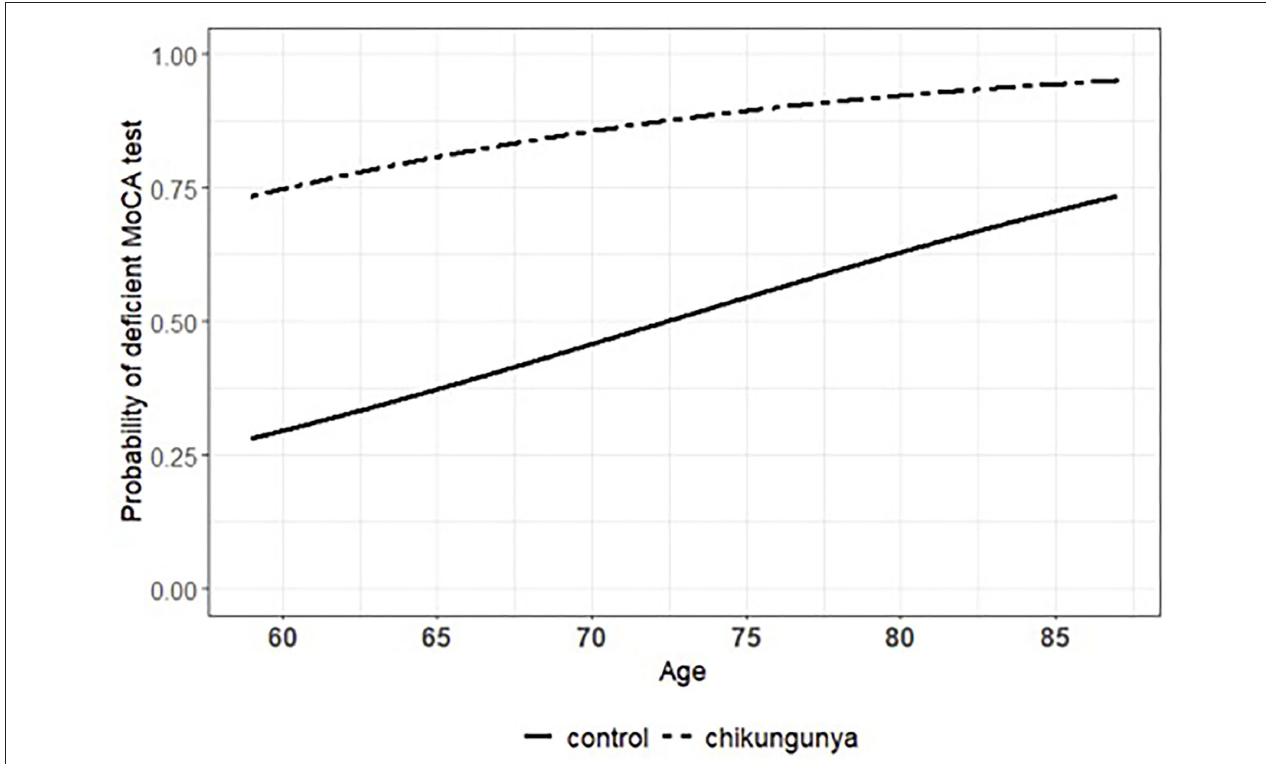
FIGURE 1 | Estimated association (or effect) of chikungunya infection and participant’s age on the probability of having the performance on the Montreal Cognitive Assessment (MoCA) test considered as impaired.